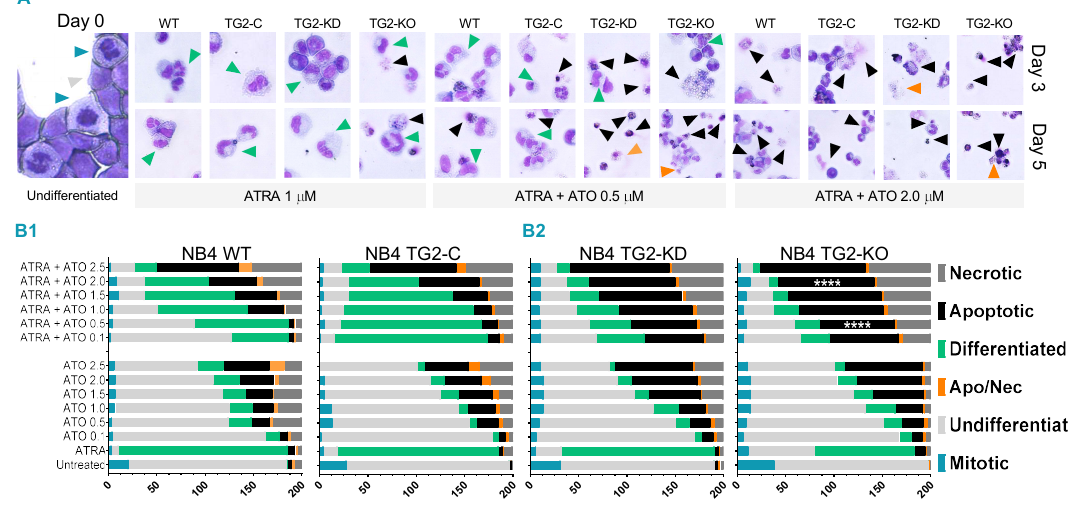
Figure 1. Tissue transglutaminase (TG2) expression moderates arsenic-induced apoptosis. ( A ) TG2 has a protective role against ATO-induced cell death, whereas its absence generates a more sensitive response to the treatment. Representative images of May–Grünwald–Giemsa staining for morphological examination of NB4 cell lines treated with 1 µ M ATRA or with ATRA + ATO (0.5 or 2.0 µ M) for three and five days ( n = 5). Light microscopic images and documentation were obtained using the FLoid ® Cell Imaging Station instrument (Life Technologies). Cell death features are marked with di ff erent triangles based on the color code listed in the lower panel. ( B1 , B2 ) Quantification of May–Grünwald–Giemsa-stained Cytospin ™ slides. From each Cytospin slide, 200 cells treated with ATRA or ATO for five days (from 0.1 µ M up to 2.5 µ M) or in a combination thereof were counted from three di ff erent fields of view, were quantified based on cell death features listed and were marked with di ff erent colors at the right side of the panels. The graphs represent the mean values of the counted cells, where the black / grey / orange colors mark the cell death features. In NB4 WT and TG2-C cells, ATRA-induced high TG2 levels were associated with lower cell death ratios compared to the TG2-KD or TG2-KO cells. Vehicle controls are in the supplement (Figure S1). Statistical significance was determined via two-way analysis of variance (ANOVA; Bonferroni post-hoc test; ATRA + ATO 2.0 WT: Apoptotic vs. ATRA + ATO 2.0 KO: Apoptotic **** p < 0,0001; ATRA + ATO 0.5 WT: Apoptotic vs. ATRA + ATO 0.5 KO: Apoptotic **** p <